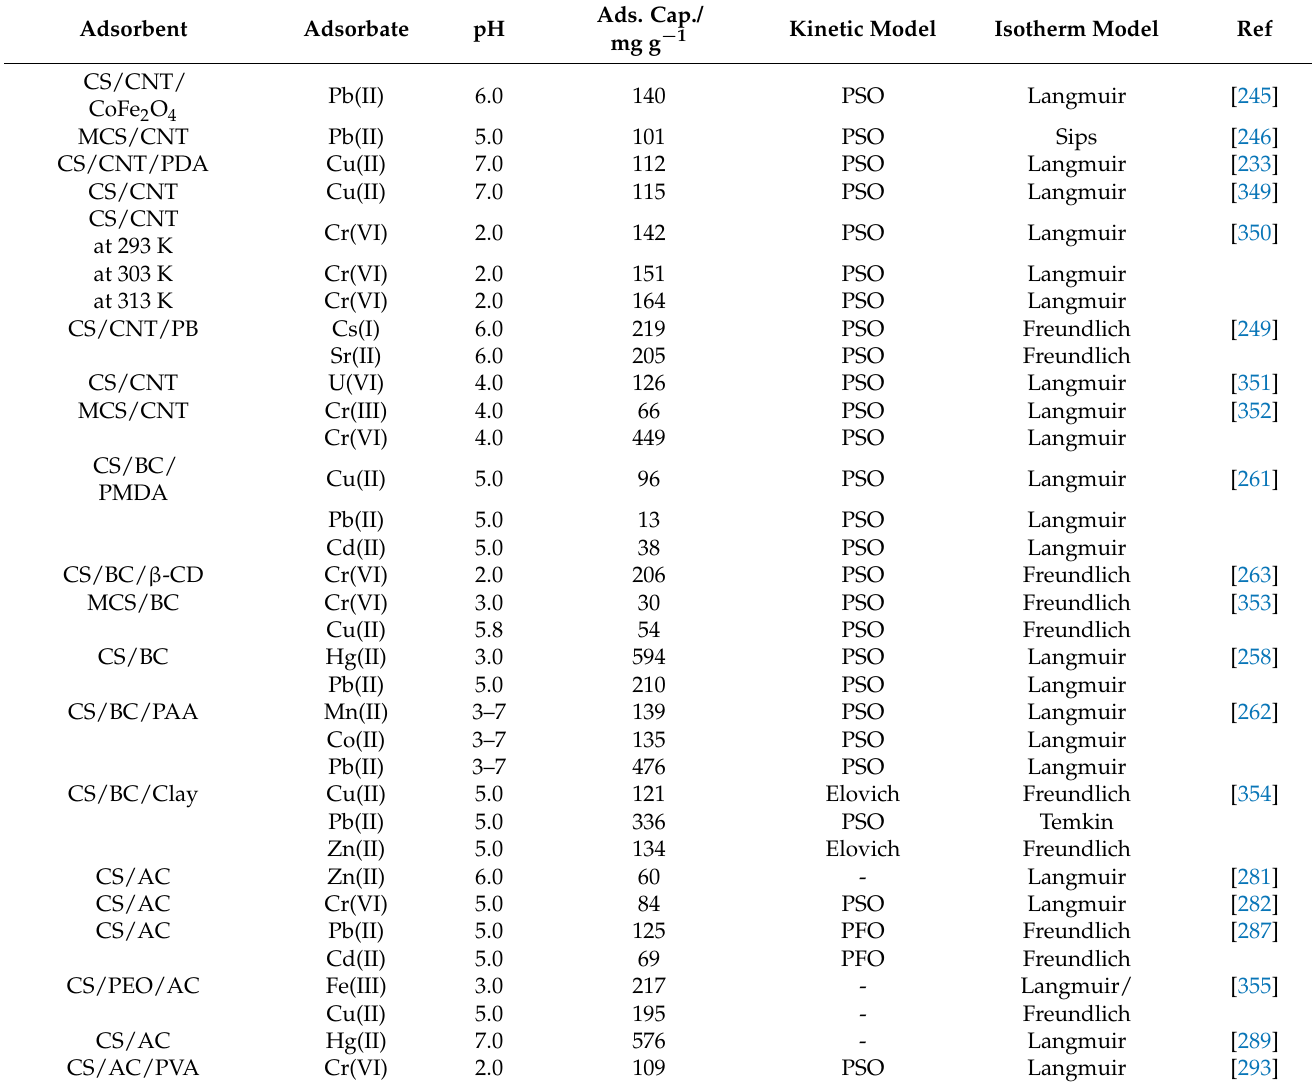
Table 6. Adsorption performance of CS/CNT, CS/BC and CS/AC composites in the removal heavy metal